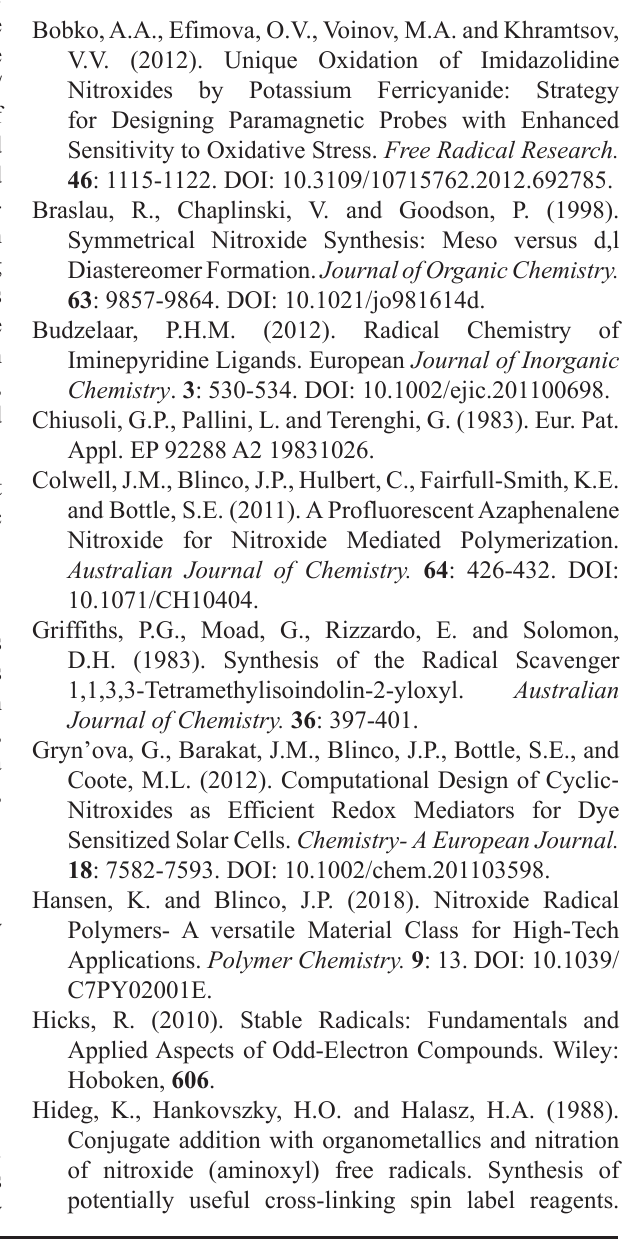
O (3.3 equiv.), Na 2 2